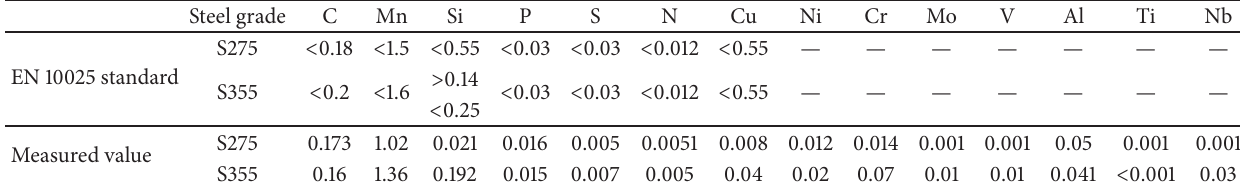
Table 1: Chemical composition of liquid alloys of S275 and S355 (%).